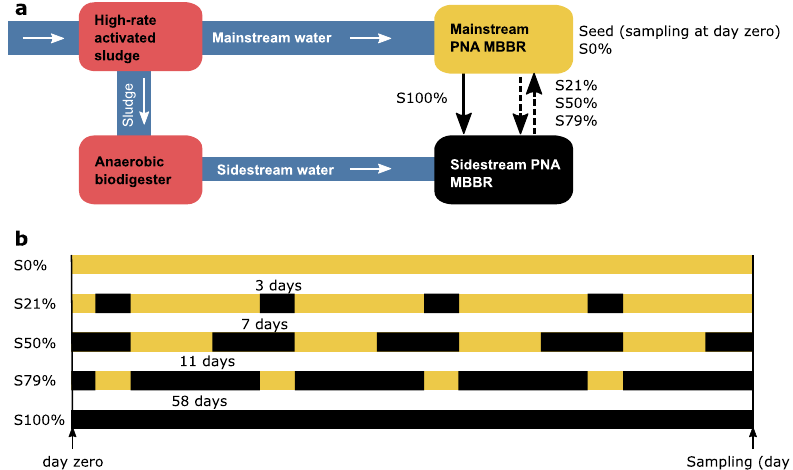
Fig. 1 Scheme of the PNA MBBRs at the Sjölunda WWTP and the experimental design. a Layout of the WWTP and the PNA MBBRs. White arrows indicate the water fl ow. The black arrows indicate transfer of bio fi lm carriers between the PNA MBBRs (yellow/black). b Bio fi lm carriers were either kept in the mainstream PNA MBBR (S0%), moved to the sidestream PNA MBBR (S100%), or moved between the mainstream and the sidestream in 2-week periods according to the time schedule (S21%, S50% and S79%). Initial samples from the mainstream PNA MBBR, at time zero were also analyzed (Seed). The 2-week rotation periods were repeated four times over the course of 58